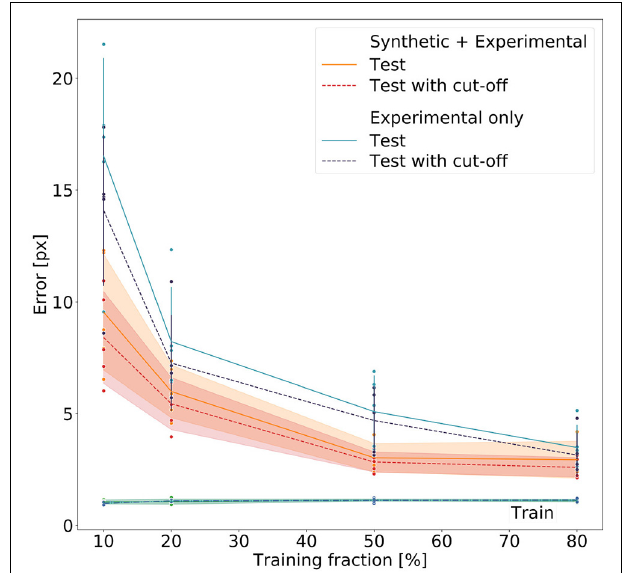
FIGURE 8 | Comparative evaluation of Experimental-only and Synthetic + Experimental models. Individual points represent different networks. Average pixel errors are plotted against the fraction of training frames in the video. Training errors (lower lines) are nearly equal for all networks. Performance of the Synthetic + Experimental models (red and yellow lines with confidence bands) was better than that of models that were trained on experimental data only (blue lines with error bars). Estimates with and without a cut-off threshold of 10 reveal a small improvement if the cut-off is applied, though this difference is not statistically significant. Each dot represents one data point. The scale factor converting pixels to mm was in the range of 0.202–0.771 mm/pixel, depending on the zoom setting of the camera (see Supplementary Table 1 ).